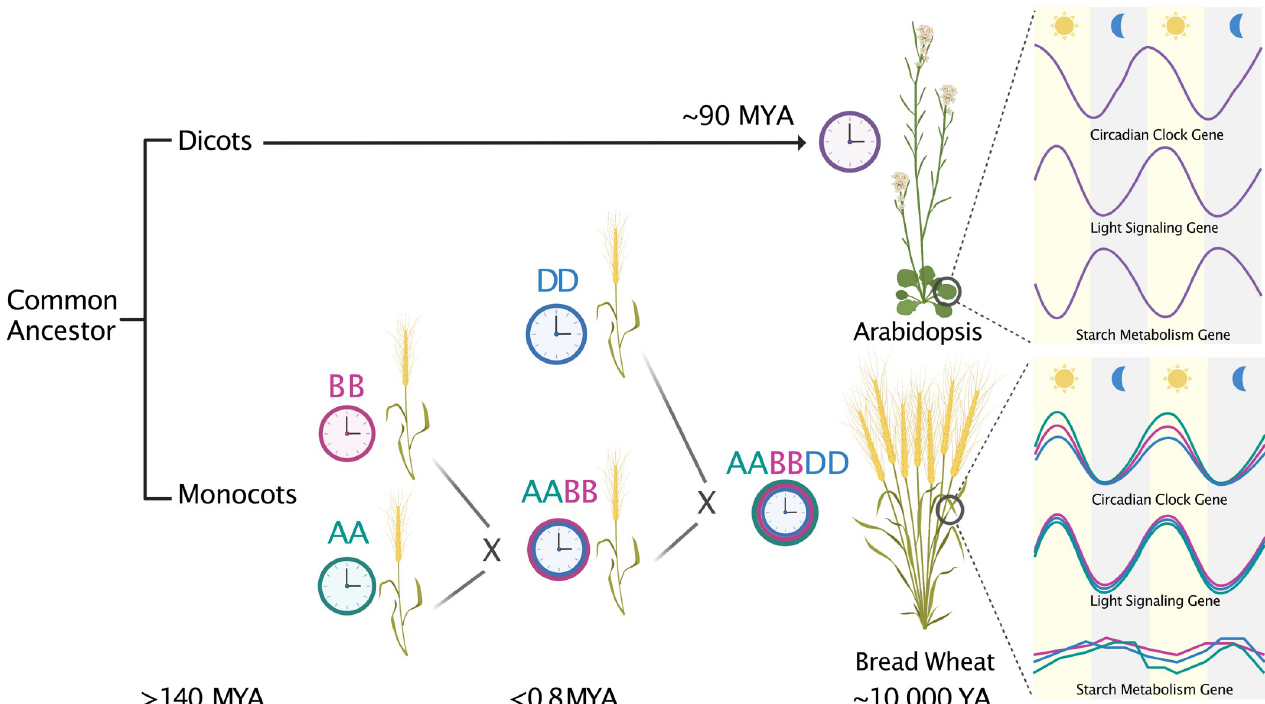
Fig 1. Clock-controlled pathways in Arabidopsis and the hexaploid wheat are largely conserved. Following the divergence of monocots and dicots over 140 million years ago (MYA), the ancestors of bread wheat evolved. Interspecific hybridization between the tetraploid (AABB) and diploid (DD) ancestors gave rise to the hexaploid (AABBDD) bread wheat we eat today. Comparisons of clock regulation of gene expression with Arabidopsis highlight examples of conservation and divergence in clock control of critical biological pathways. The temporal patterns of expression for circadian clock and light signaling genes are largely conserved, although clock genes retained in 3 copies often varied in amplitude across the subgenomes and had a 3.5-h longer mean period than Arabidopsis . Starch metabolism has diversified in terms of clock control of transcript abundance for genes within the pathway suggesting altered regulation of this process. Created with